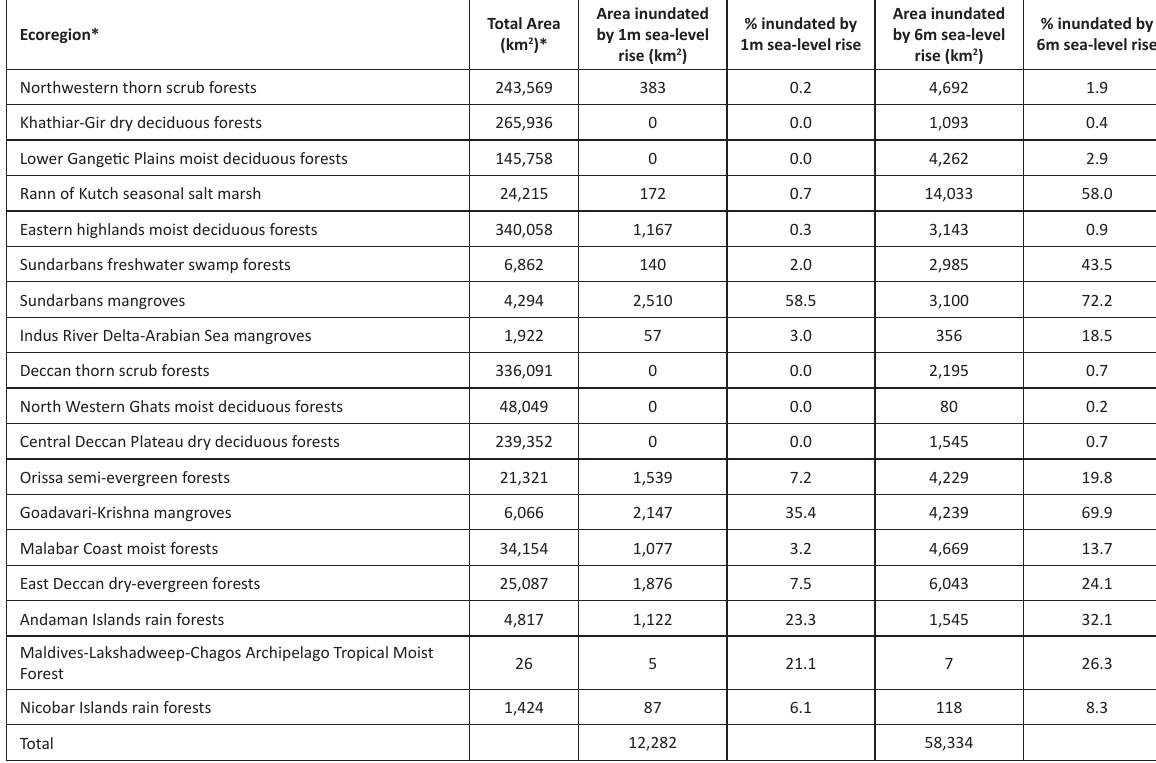
* Source: Rodgers & Panwar (1988), Rodgers et al. (2000), Islam & Rahmani